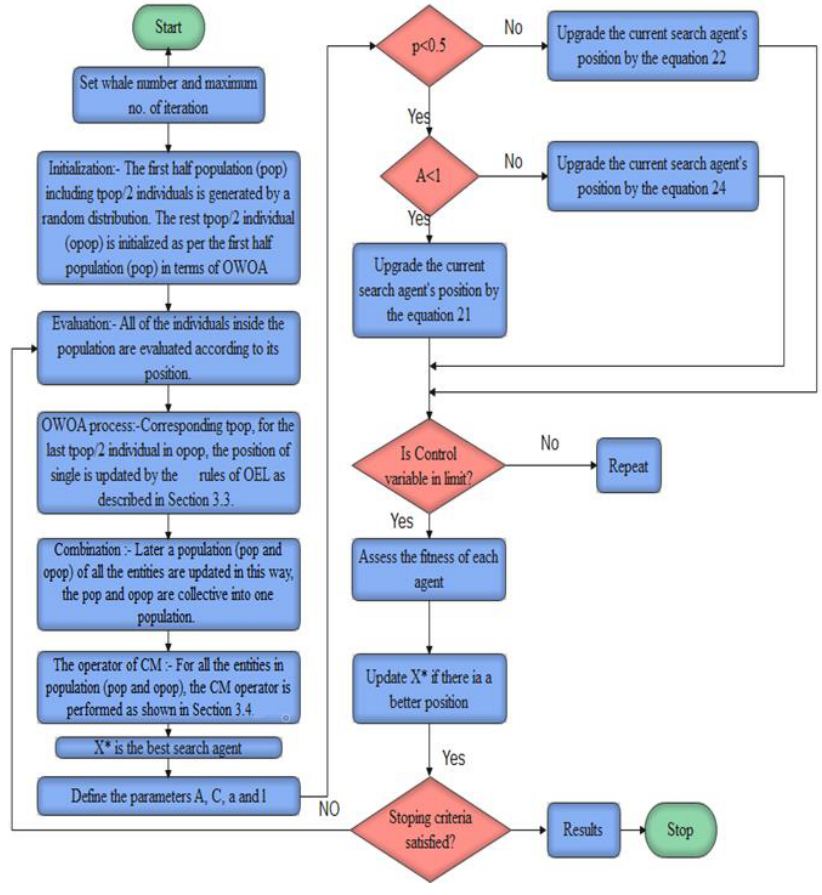
Figure 5. Flowchart of